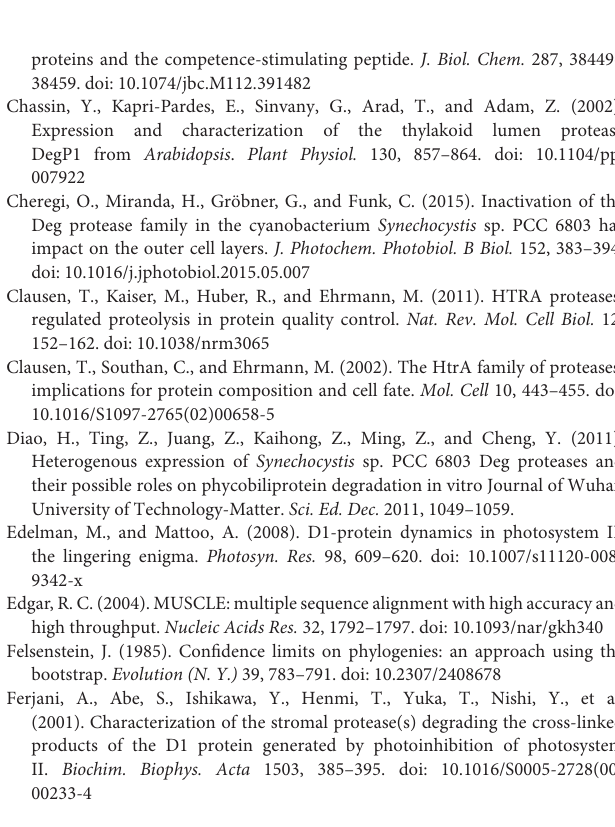
TABLE S1 | Nomenclature information of cyanobacterial strains used in the phylogenetic tree in Figure 1. TABLE S2 | Summary of Deg genes expression in microarray and RNA sequencing experiments extracted from the Cyanoexpress (Hernandez-Prieto and Futschik,